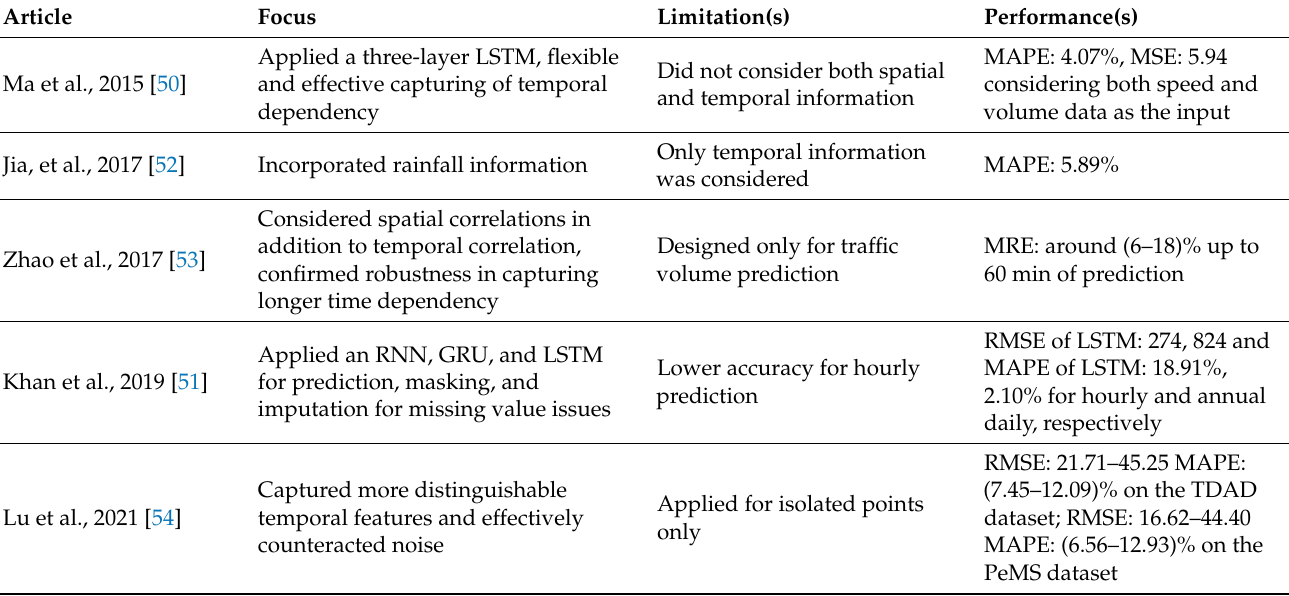
Table 6. Summary of the works found using